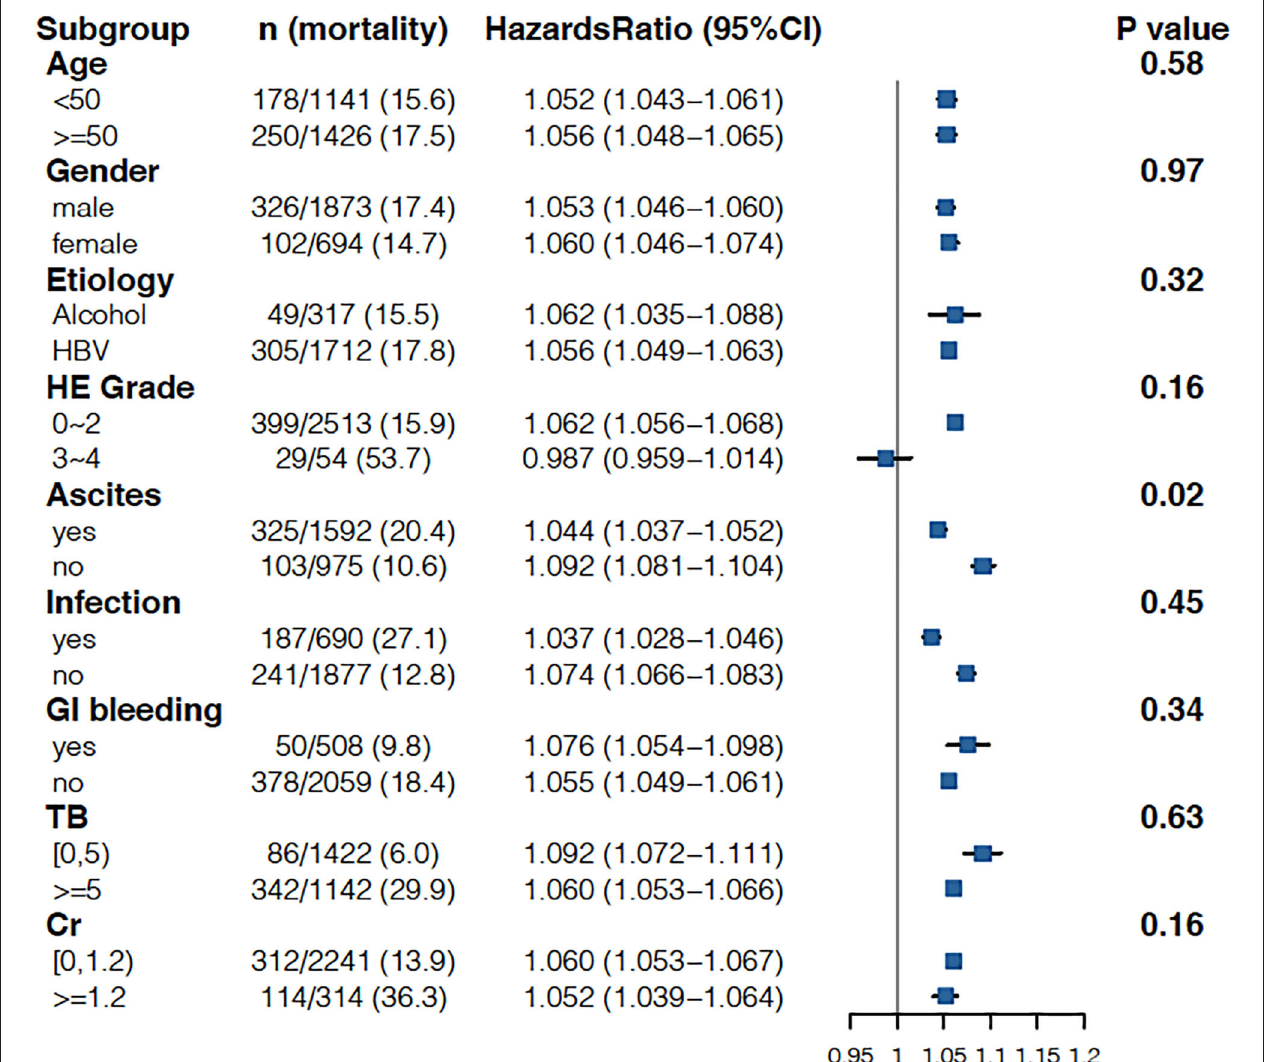
FIGURE 3 | Stratified analyses of adjusted risk of 90-day LT-free mortality in cirrhosis patients according to strata of baseline covariates INR. HBV, hepatitis B virus; HE, hepatic encephalopathy; GI bleeding, gastrointestinal bleeding; TB, total bilirubin; Cr, creatinine; INR, international normalized ratio.